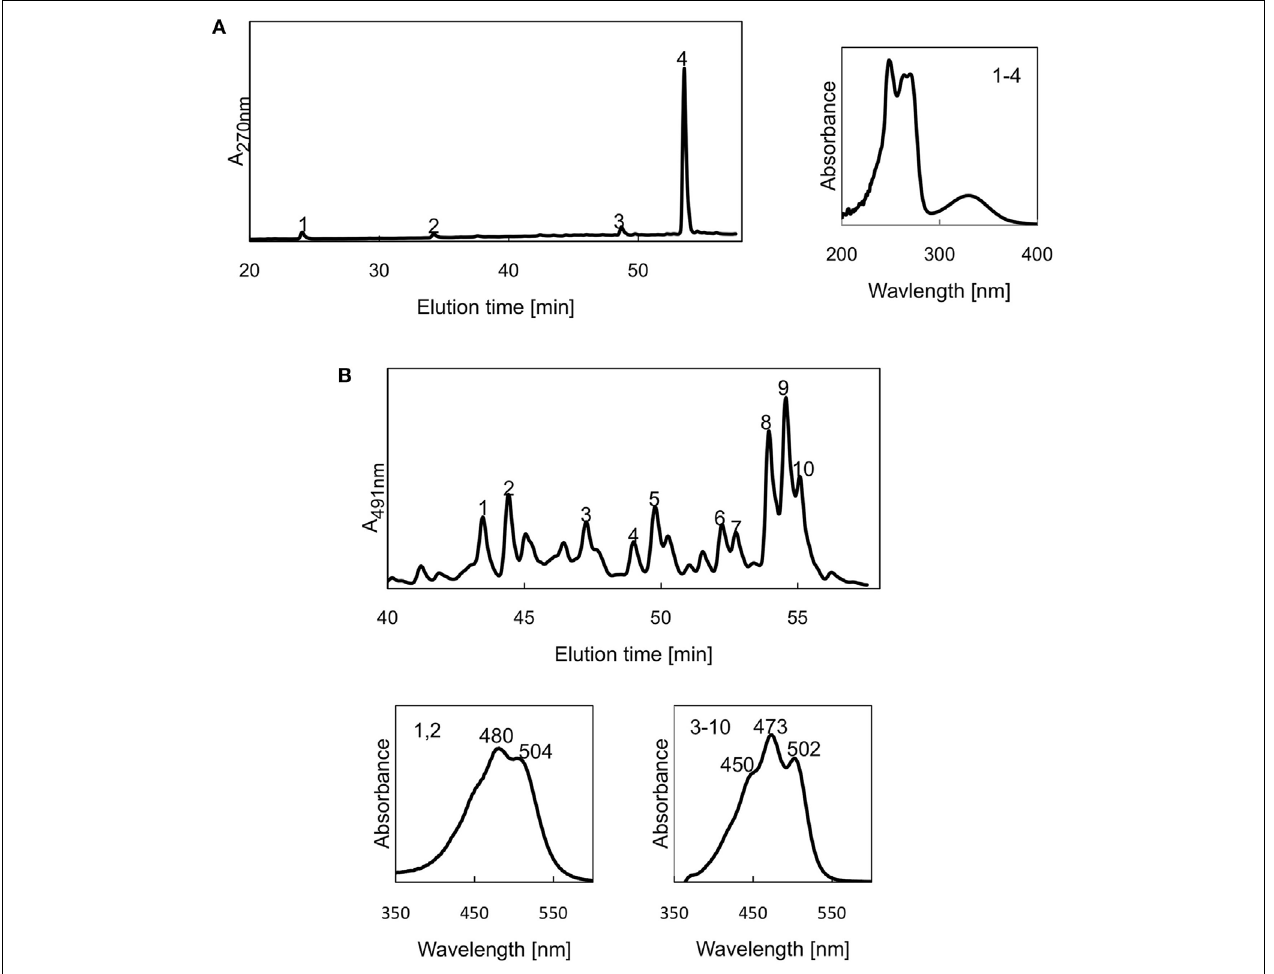
at 270nm. Peaks 1–4, menaquinones. (B) Elution profile monitoring absorbance at 491nm. Peaks 1, 2, deoxyflexixanthin derivatives; peaks 3-10 1 (cid:2) -hydroxytorulene